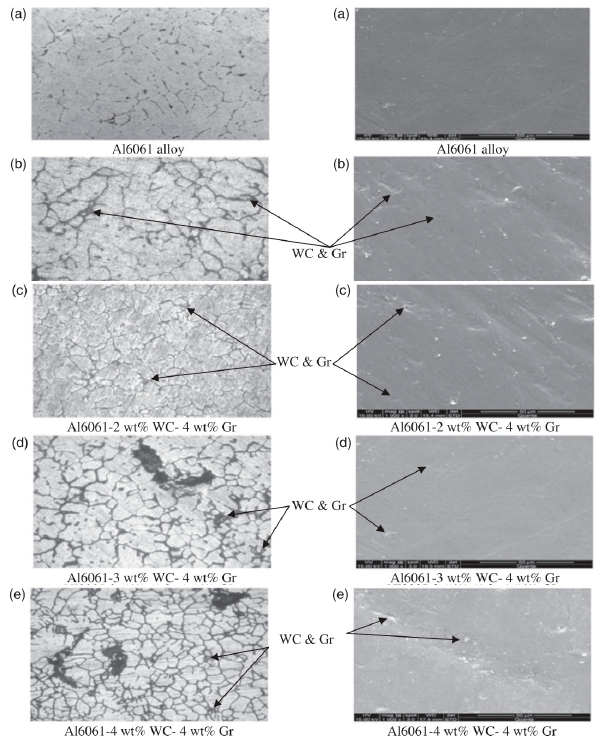
Figure 12. Optical micrographs of Al6061 alloy and its WC and Gr-reinforced HMMCs, ( a ) Al6061 alloy; ( b ) Al6061-1 wt.% WC-4 wt.% Gr; ( c ) Al6061-2 wt.% WC-4 wt.% Gr; ( d ) Al6061-3 wt.% WC-4 wt.% Gr; and ( e ) Al6061-4 wt.% WC-4 wt.% Gr [86].